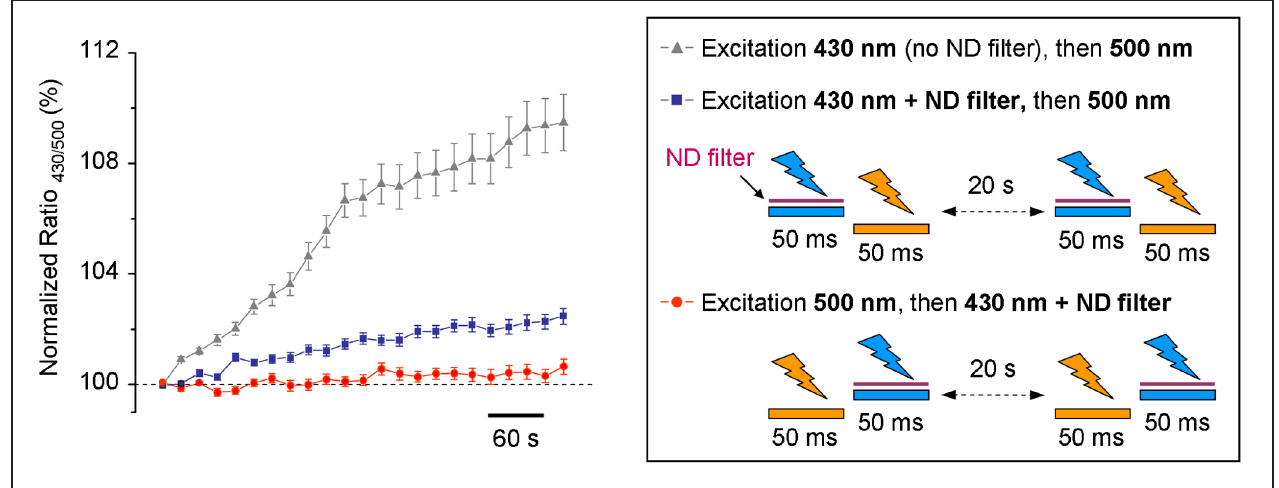
FIGURE 4 | Time-dependent change of the R 430 / 500 at resting conditions measured using different protocols. The trace with triangles illustrates the results obtained using the non-modified light pass and